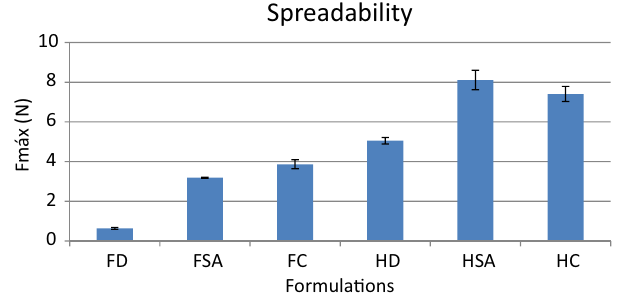
FIGURE 2 – Spreadability (Maximum force in N) of the formulations containing dithranol (FD and HD) and solid dispersions of dithranol in stearic acid and argan oil (FSA and HSA) and in glyceryl behenate (FC and